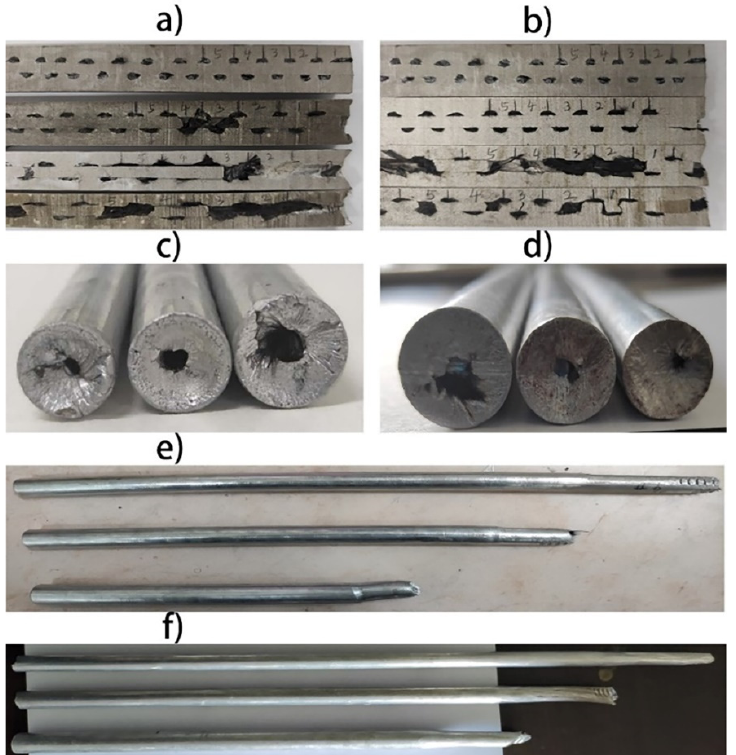
Figure 13. Comparison of specimens after different drawing: ( a ) center section of five-pass drawing; ( b ) center section of multi-pass drawing; ( c ) tail crater of five-pass drawing; ( d ) tail crater of multi-pass drawing; ( e ) post-drawing specimen after five-pass drawing; ( f ) post-drawing specimen after multi-pass drawing.